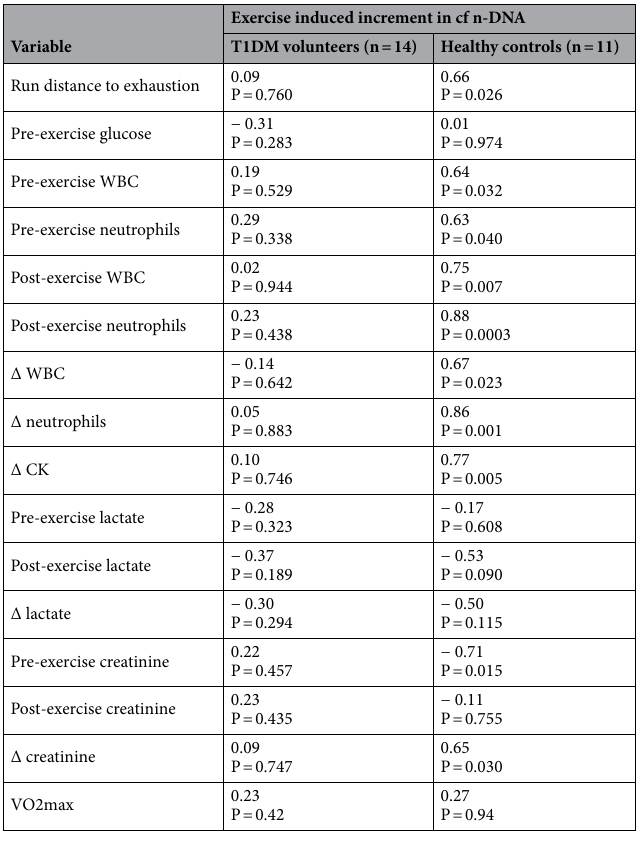
Table 4. Correlations (r) between exercise-induced increment in cf n-DNA (Δ cf n-DNA) and selected variables in the group of T1DM volunteers (n = 14) and healthy controls (n = 11). WBC white blood cell, CK creatine kinase, Δ exercise induced increment in given variable, other details as for Table 2. Due to technical problems, one subject with T1DM had no blood cell count. Therefore, correlations between Δ cf n-DNA and WBC as well between Δ cf n-DNA and neutrophils were calculated from 13 cases for the T1DM